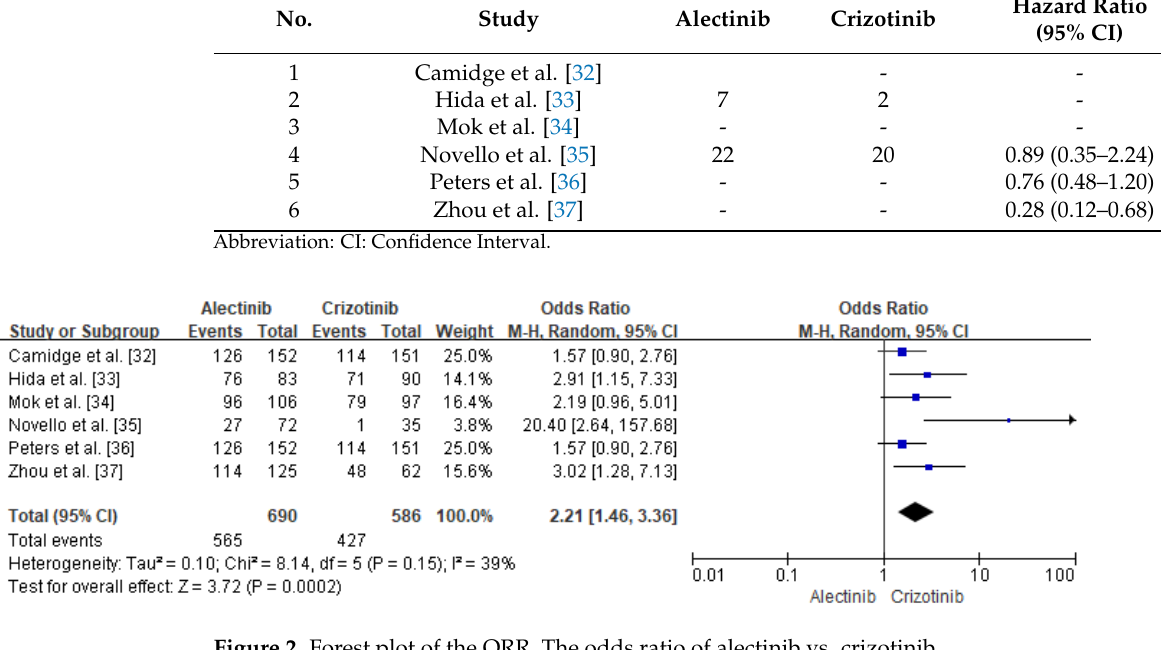
Figure 2. Forest plot of the ORR. The odds ratio of alectinib vs. crizotinib.